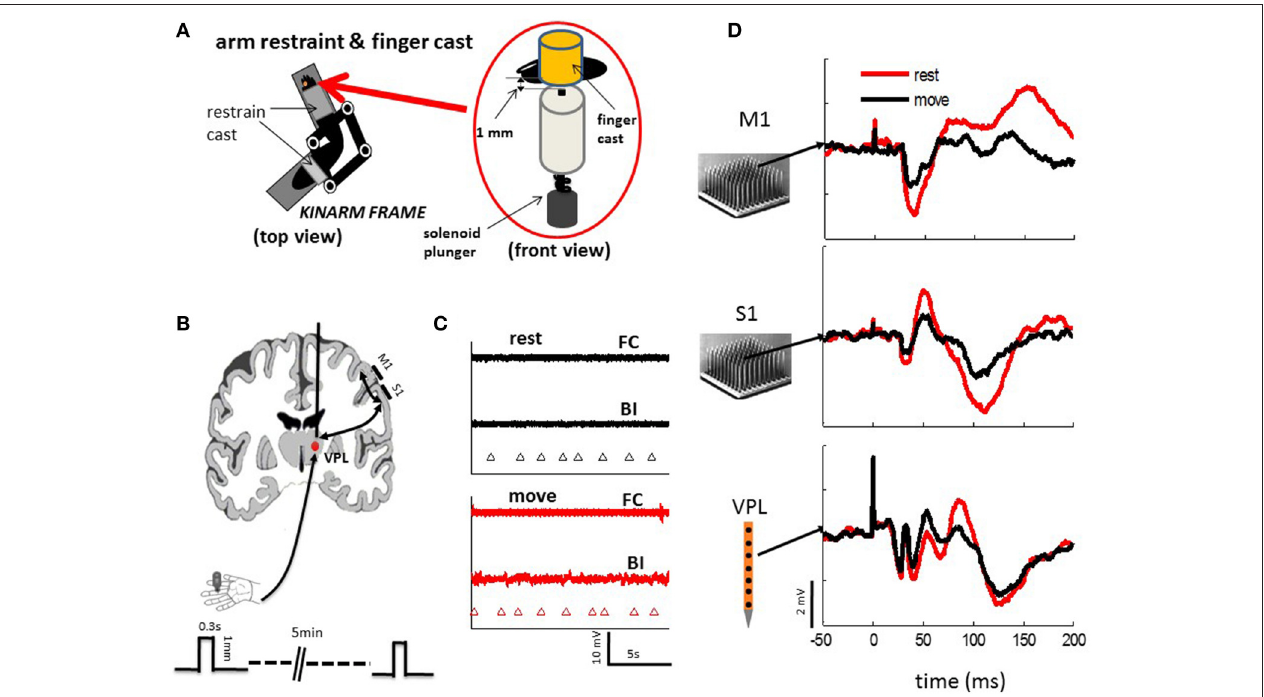
FIGURE 1 | Experimental setups. (A) Monkeys were seated comfortably in a non-human primate chair with their right arm and hand restrained on a KINARM (BKIN Technologies), which allows free movement of the arm in the horizontal plane. The fingers are held in place by cast that allows tactile stimuli to be delivered reliably from a solenoid plunger under both the resting condition and passive movement of the arm. (B) Neuronal activities were recorded from electrode arrays in M1 and S1 (10 by 10, Blackrock Microsystems) or S1 and VPL (24 sites linear array, Microprobes Com) during tactile stimulation to the finger pad. Three-hundred to six-hundred stimuli were randomly delivered via the tactile stimulator (A) at a mean frequency of 0.5Hz under resting and passive arm movement. Each tactile stimulus (one stroke of solenoid) was applied for 0.3s on the skin, which indents the finger pad of either index, middle, or ring finger by 1mm. (C) EMG activities from the major muscle were (BI, biceps; FC, flexor carpi) recorded during rest and movement. There were no obvious active movements observed during either rest or passive movement. Triangle marker indicate the time of tactile stimulation. (D) Example evoked responses from a single channel of each array in M1, S1, and VPL show from typical